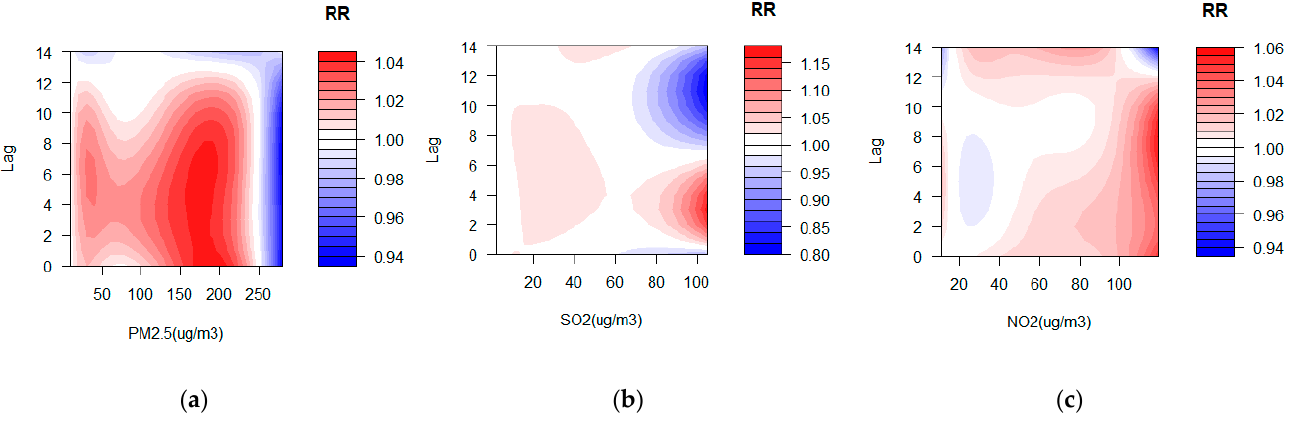
Figure 1. Contour plots of the exposure–lag-response effects between ambient pollutants and outpatient visits for pneumonia. Note: After adjusting for long-term trends, day-of-the-week effects, and meteorological factors, the distributed lag nonlinear model (DLNM) was used to obtain contour plots, with the first percentile concentration of air pollutants as the reference. ( a ): PM 2.5 ; ( b ): SO 2 ; ( c ): NO 2